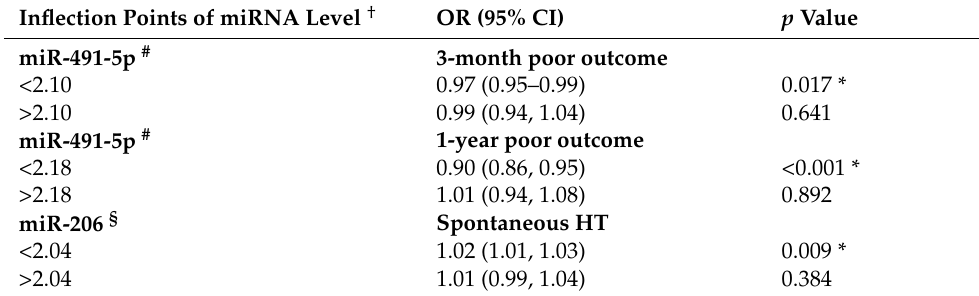
Table 4. The results of the two piecewise linear regression